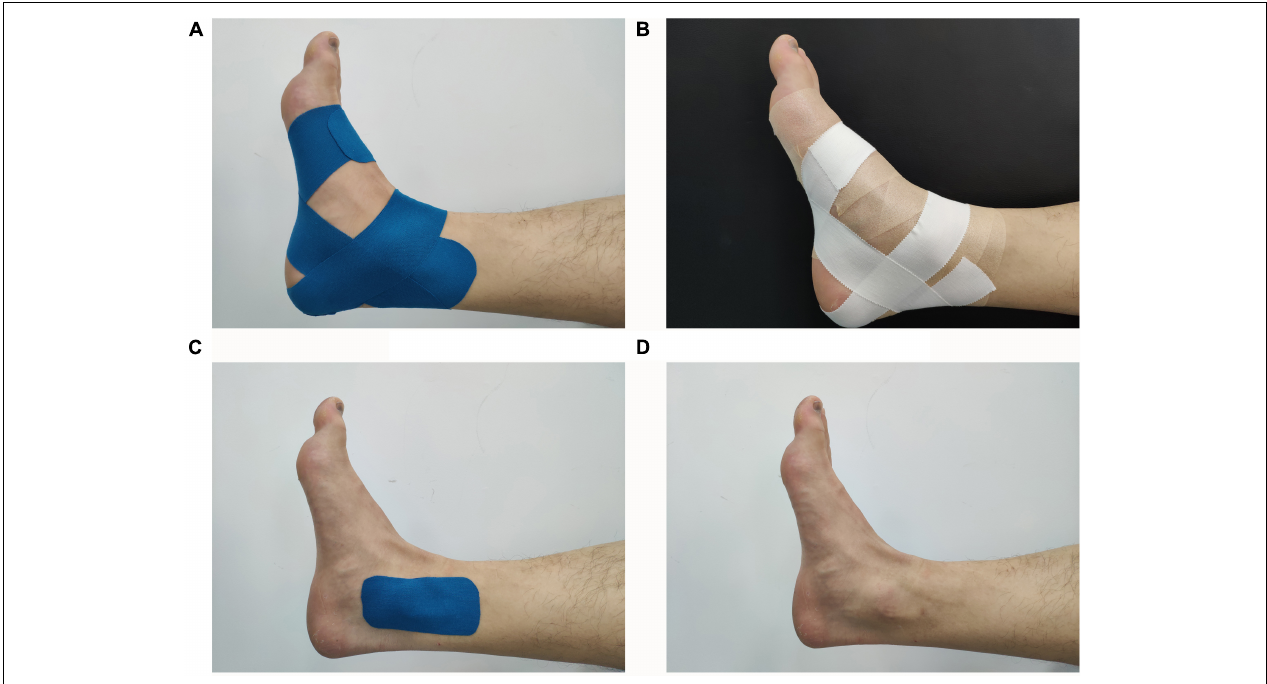
FIGURE 1 | Different ankle taping treatments. (A) Kinesiology tape, (B) athletic tape, (C) sham tape, and (D) no tape.